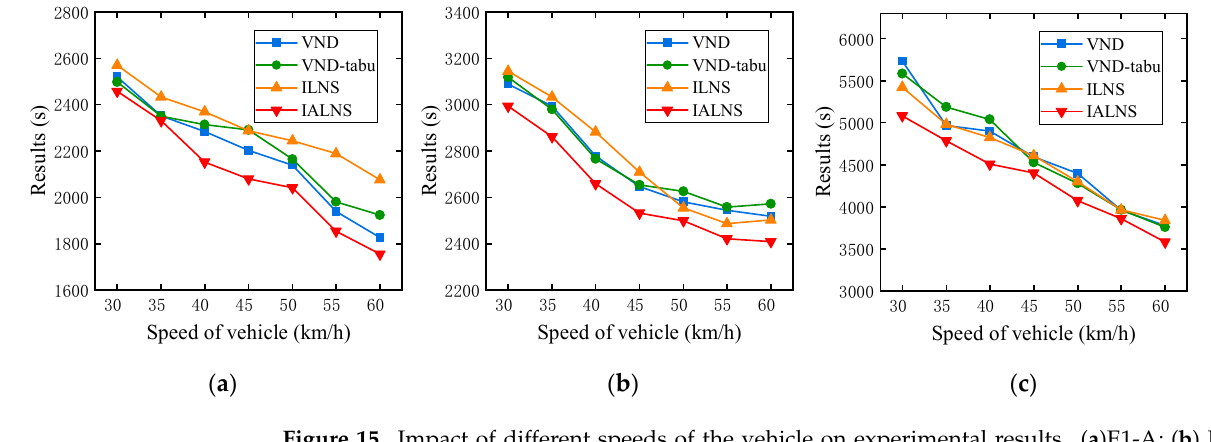
Figure 15. Impact of different speeds of the vehicle on experimental results. ( a )E1-A; ( b ) E2_A; ( c ) Table 8. Experimental results of each algorithm under different speeds of the vehicle.